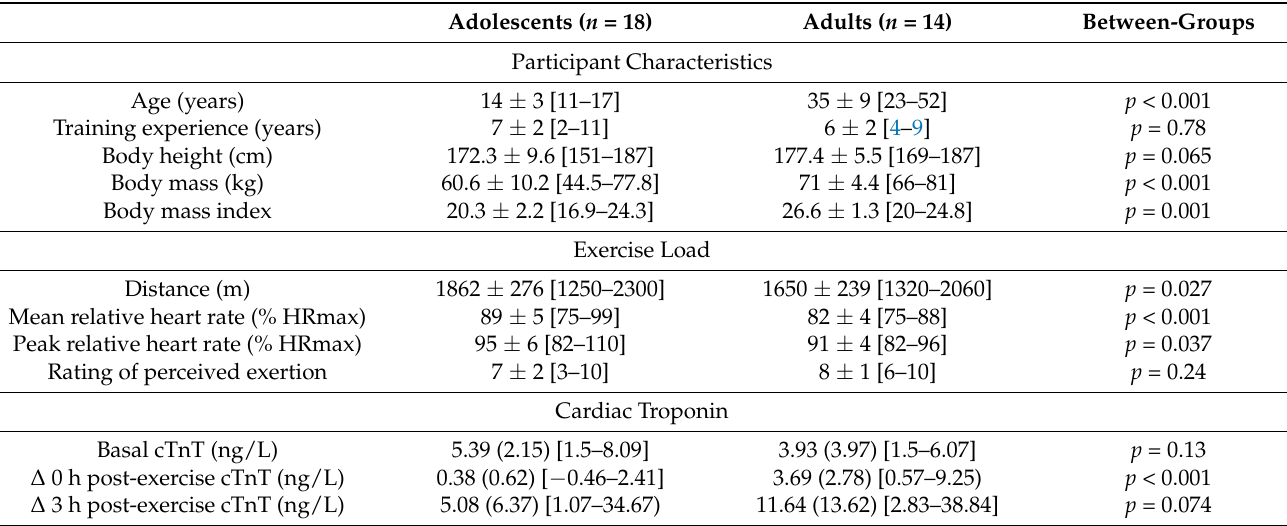
Table 1. Summary of participants’ characteristics and exercise